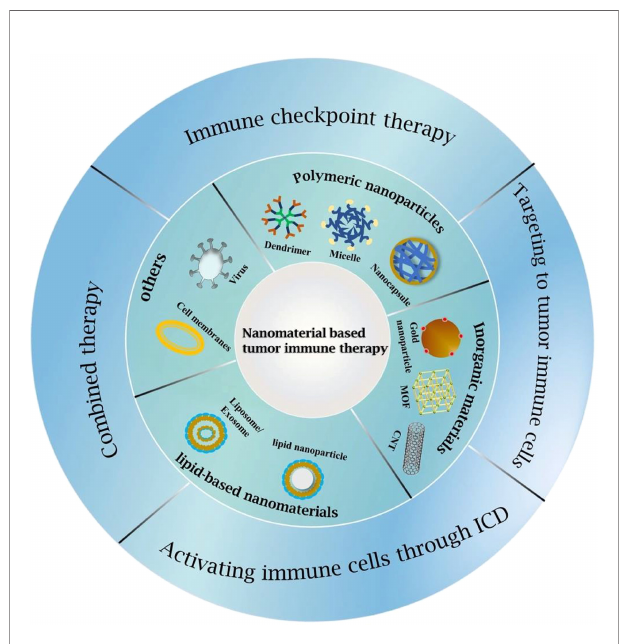
FIGURE 2 | Classi fi cations of GBM immunotherapy strategies and nanomaterials used for GBM